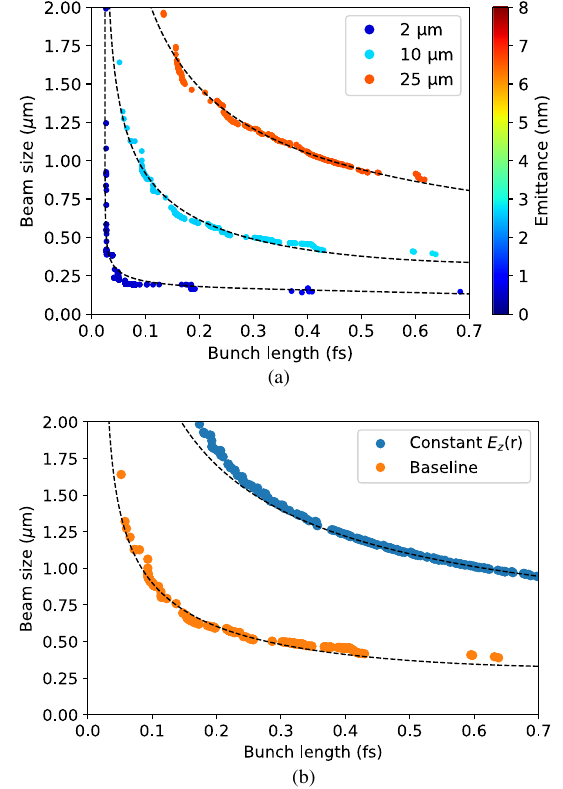
FIG. 3. (a) Dependence of achievable bunch length on final beam size in the absence of space charge forces for three different initial laser sizes: 2, 10, and 25 μ m (dots), compared to a simple model (lines). Here the MTE is 35 meV, and so these laser sizes correspond to normalized source emittances of 0.5, 2.6, and 6.5 nm, respectively. (b) Comparison between optimizations using the default cavity field maps and ones without radial dependence of the accelerating fields. In both cases, an initial laser size of 10 μ m was used.